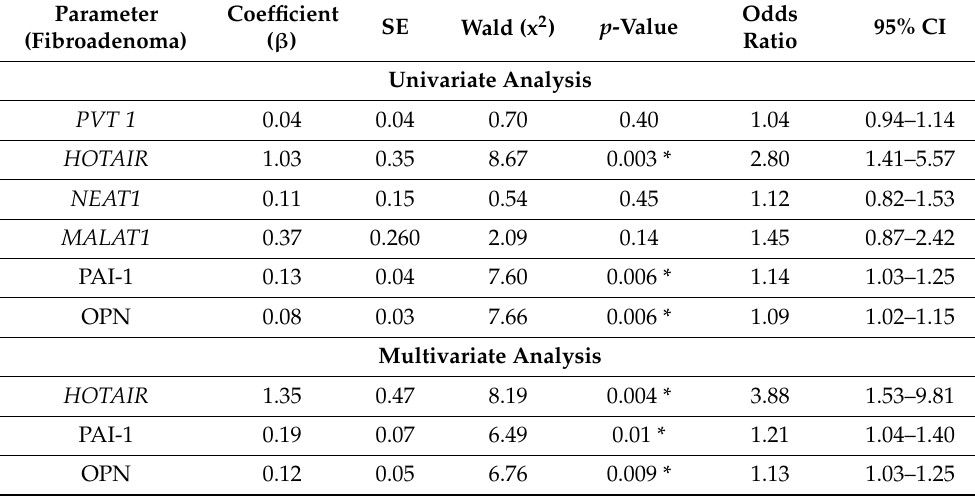
Table 8. Logistic regression analysis of PVT1, HOTAIR, NEAT1, MALAT1, PAI-1, and OPN to predict breast cancer risk in patients with fibroadenoma. Parameter